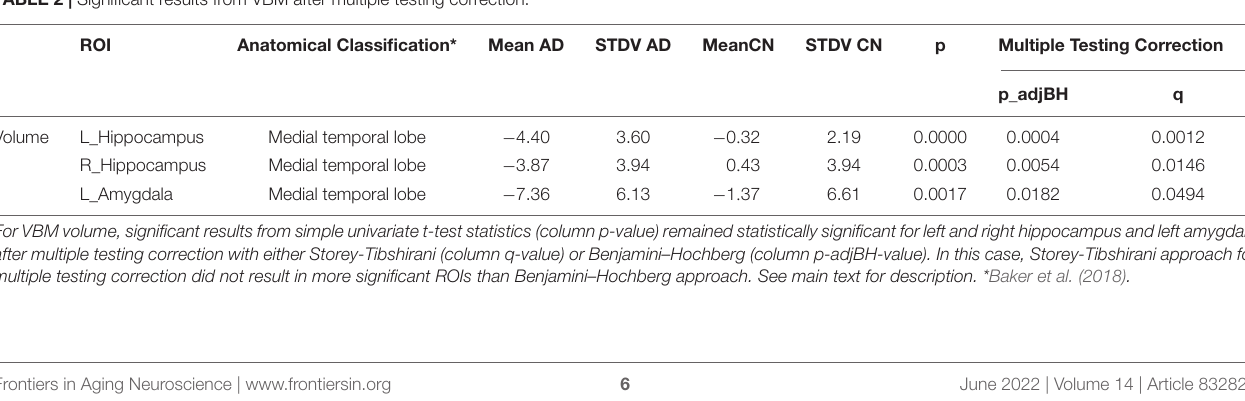
TABLE 2 | Significant results from VBM after multiple testing